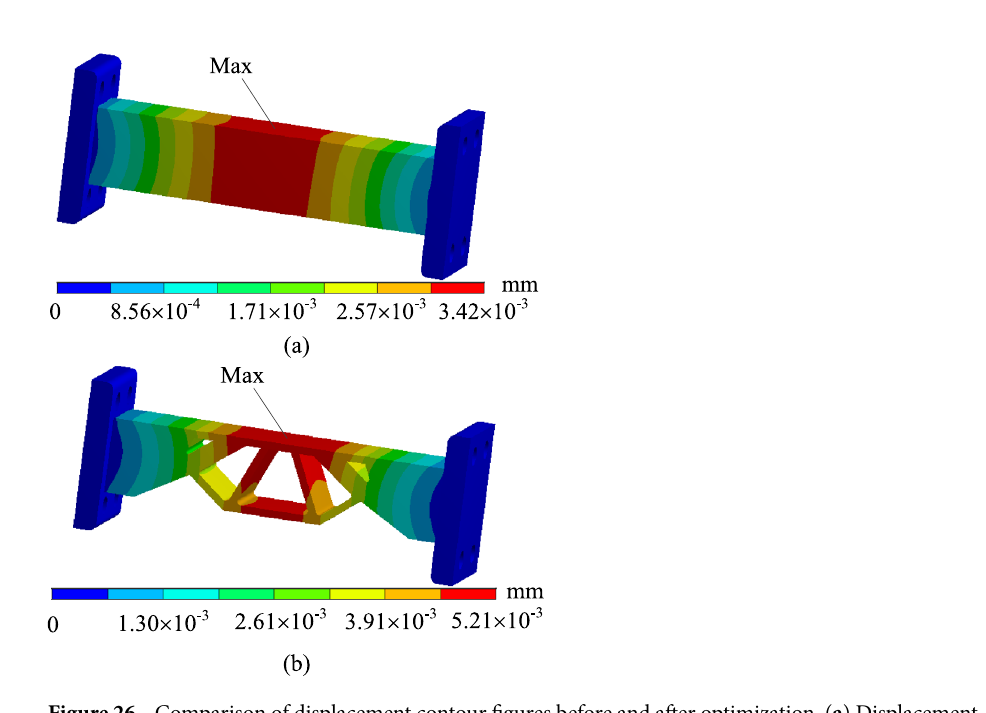
Figure 26. Comparison of displacement contour figures before and after optimization. ( a ) Displacement contour figure of the original model ( b ) Displacement contour figure of the reconstructed